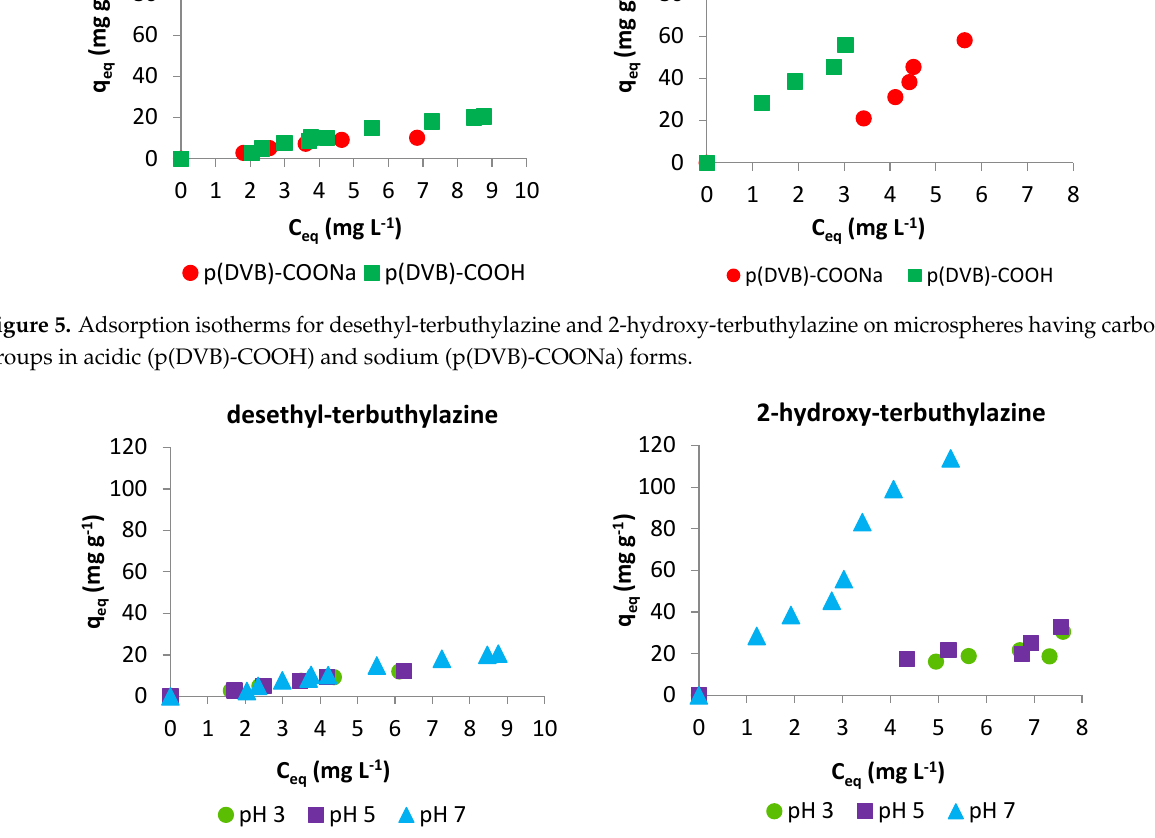
Figure 6. Adsorption isotherms for desethyl-terbuthylazine and 2-hydroxy-terbuthylazineat different pH: 3, 5 and